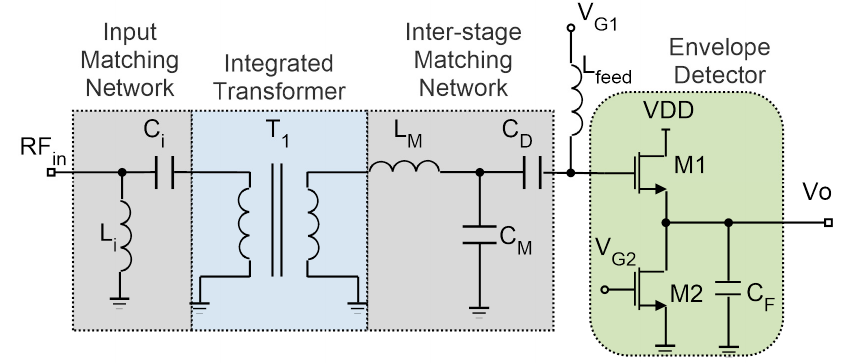
Figure 8. Schematic of the MOSFET-based RFED WuR with integrated transformer.